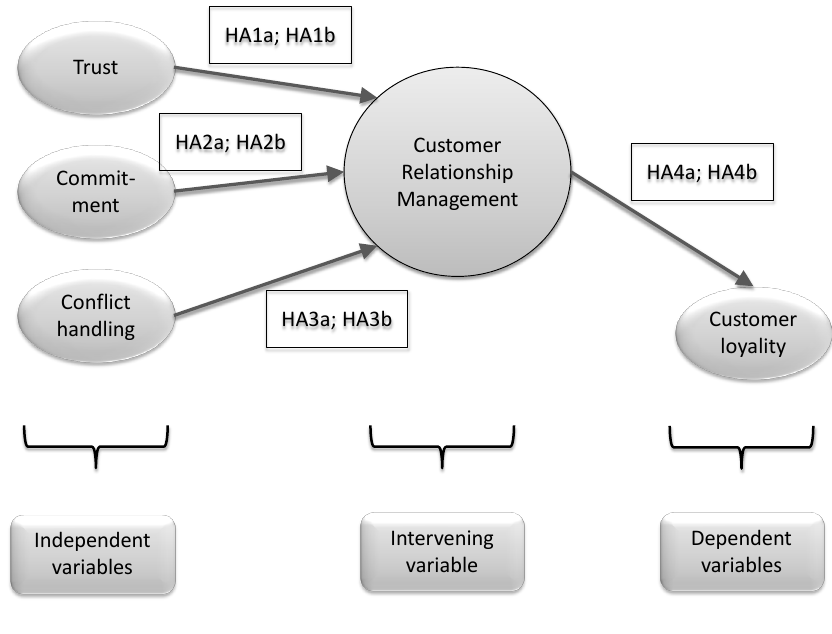
FIGURE 1: Conceptual model – Life and non-life insurance industry Source: Researcher’s